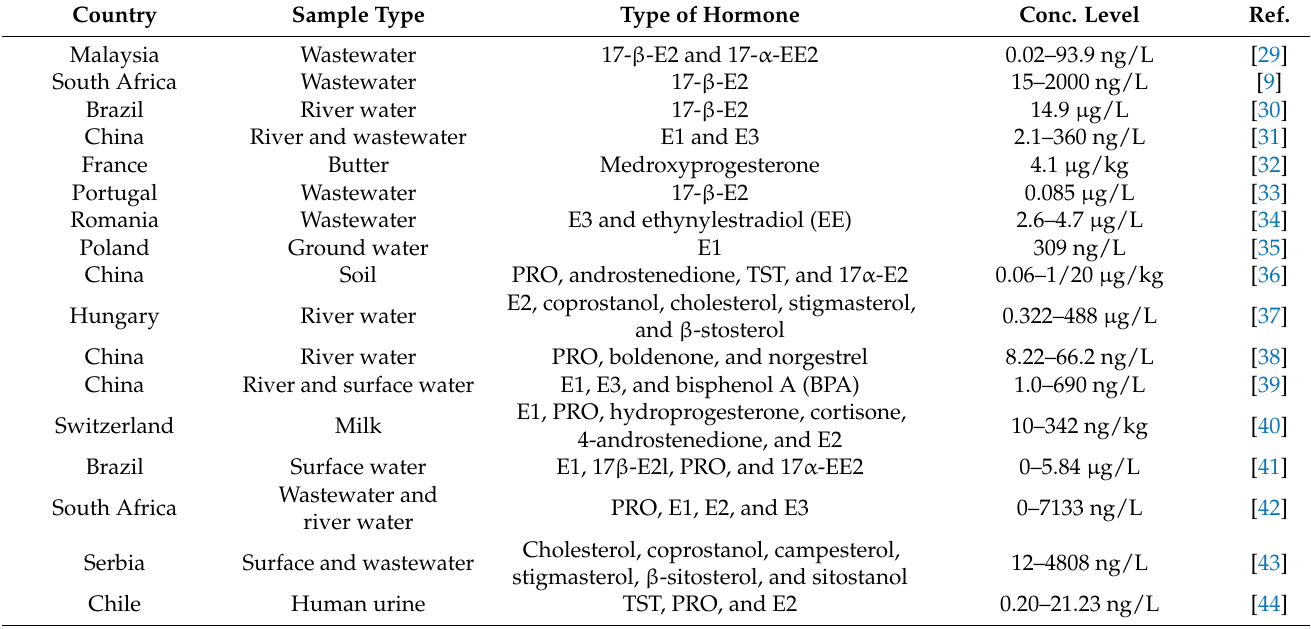
Table 1. Global hormone concentration